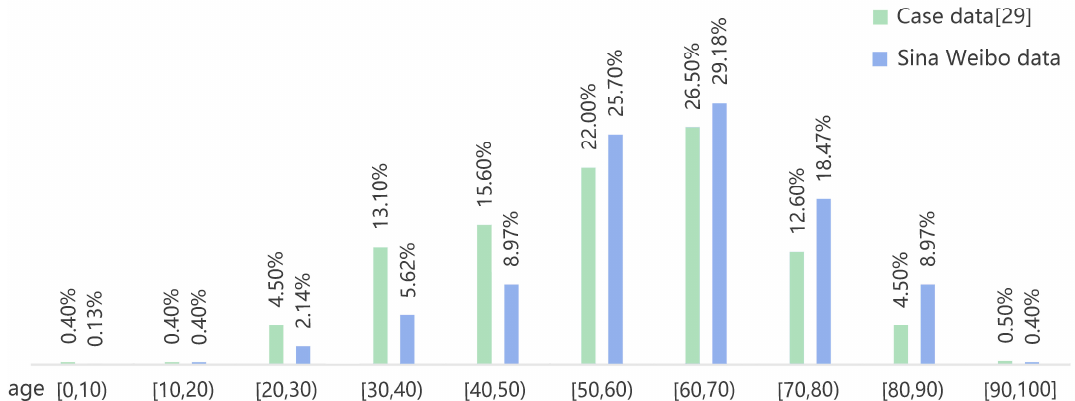
Figure 7. Histogram of patient age distribution of case data and Weibo data.